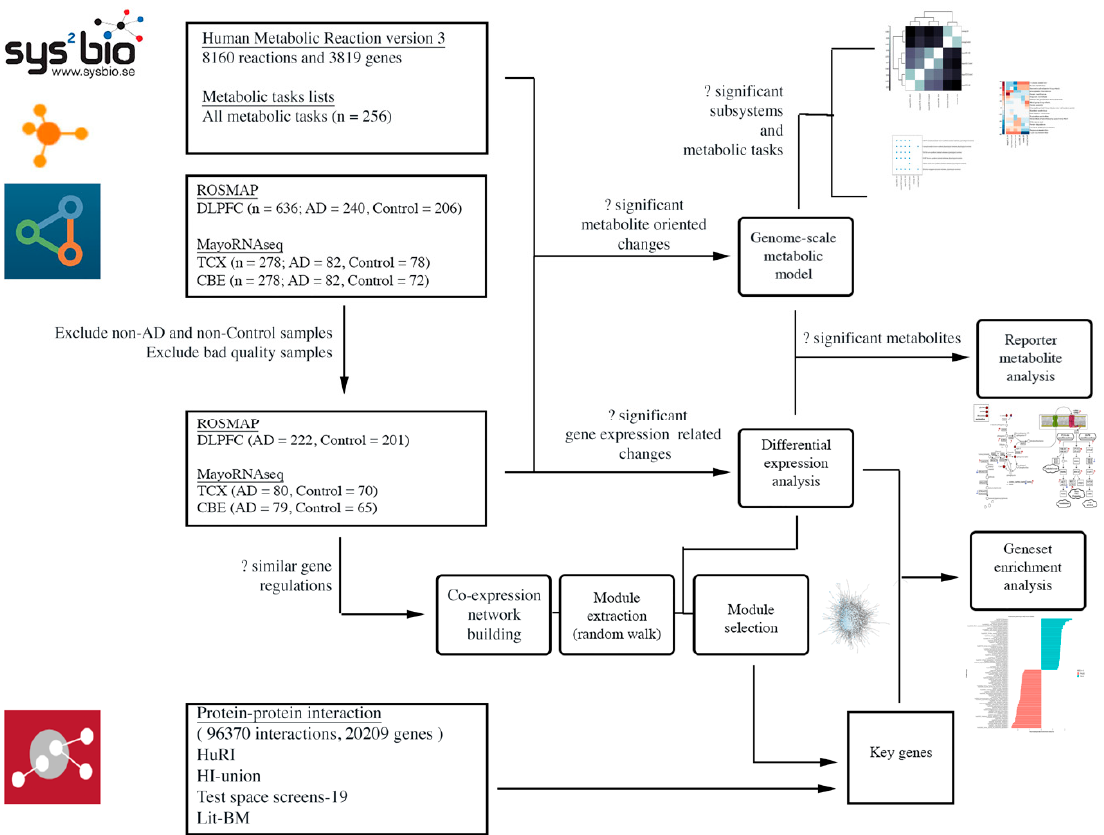
Figure 2. Workflow diagram.